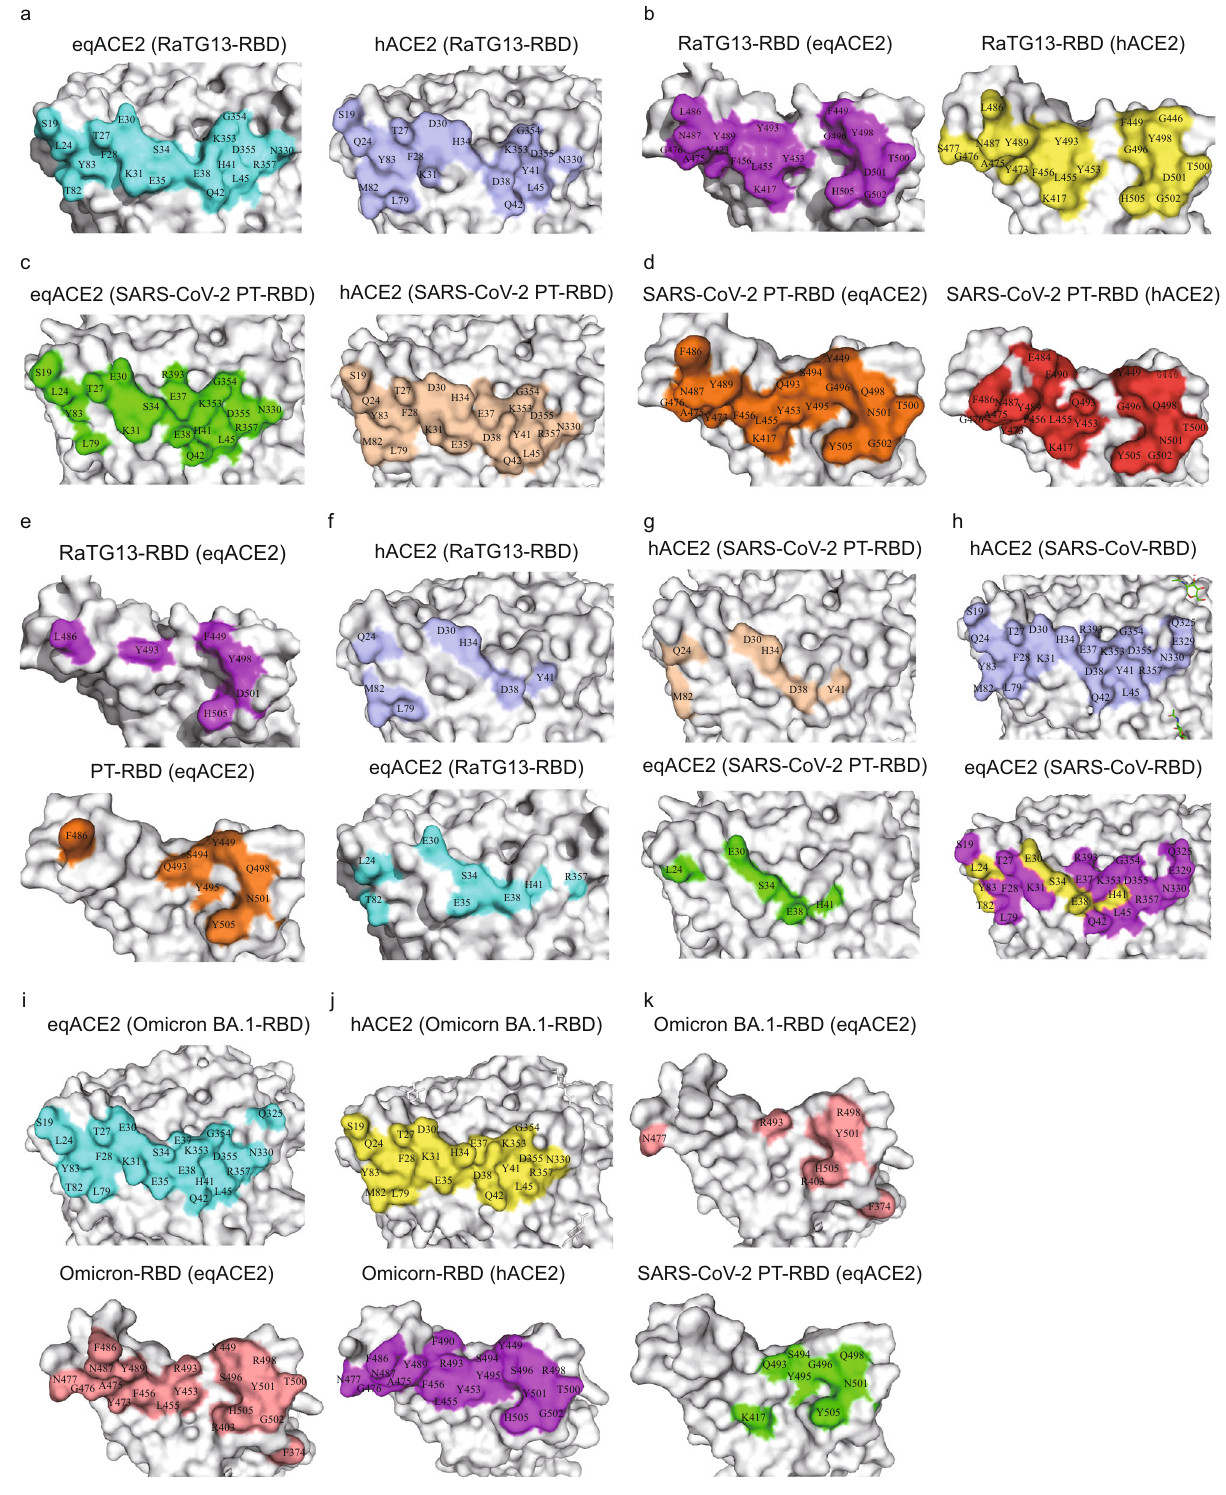
Fig. 3 Interface comparison among ACE2 orthologs binding with RaTG13-RBD, SARS-COV-2 PT-RBD, SARS-CoV-RBD and Omicron BA.1-RBD. a – d Binding interface of eq ( a , left) and hACE2 ( a , right) with the RaTG13-RBD ( b ), and the corresponding interface of eq and hACE2 binding to the SARS- COV-2 PT-RBD ( c , d ). e – g Interface difference of the RBDs between the eqACE2/RaTG13-RBD and eqACE2/SARS-COV-2 PT-RBD complexes ( e ), ACE2s between the eqACE2/SARS-COV-2 PT-RBD and hACE2/SARS-COV-2 PT-RBD complexes ( f ), and ACE2s between the eqACE2/RaTG13-RBD and hACE2/RaTG13-RBD complexes ( g ). h Binding sites of hACE2 (up, light blue) and its corresponding residues in eqACE2 (purple, down). Particularly, substitutions of referred residues are labelled in yellow. i , j The binding interface of eqACE2/Omicron BA.1-RBD ( i ) and hACE2/Omicron BA.1-RBD ( j ) are shown and the interacting residues are labeled. k The distinctive interacting residues of RBDs between eqACE2/Omicron BA.1-RBD and eqACE2/SARS- COV-2